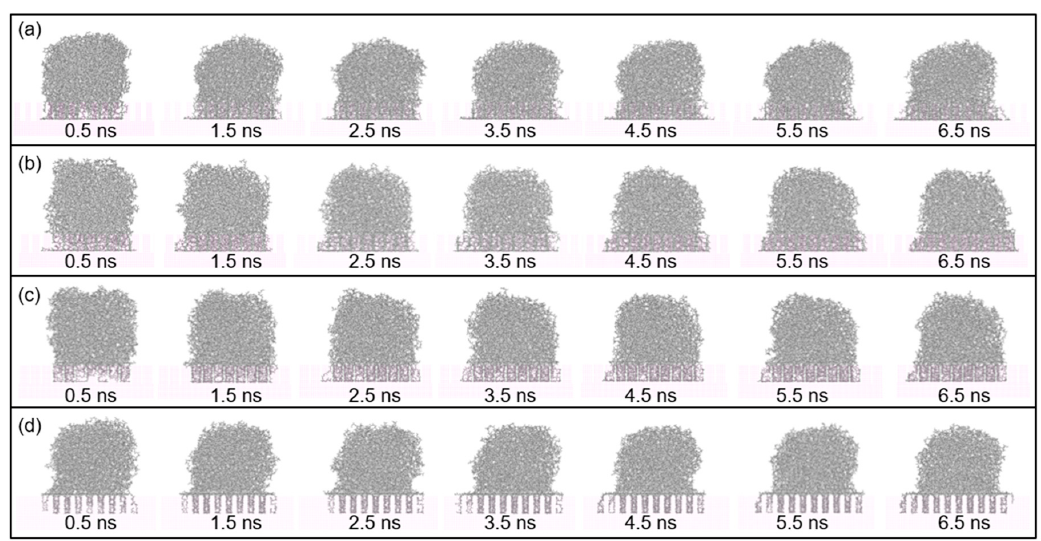
Figure 4. ( a ) height of mass center and ( b ) interaction energy as a function of simulation time, ( c ) calculation of contact angle and base radius and ( d ) contact angle and base radius of PP droplets on Al surface at different temperatures. The temperature of PP droplet was ranging from 383 K, 413 K, 443 K, 473 K to 503 K. Polymers 2020 , 12 , x